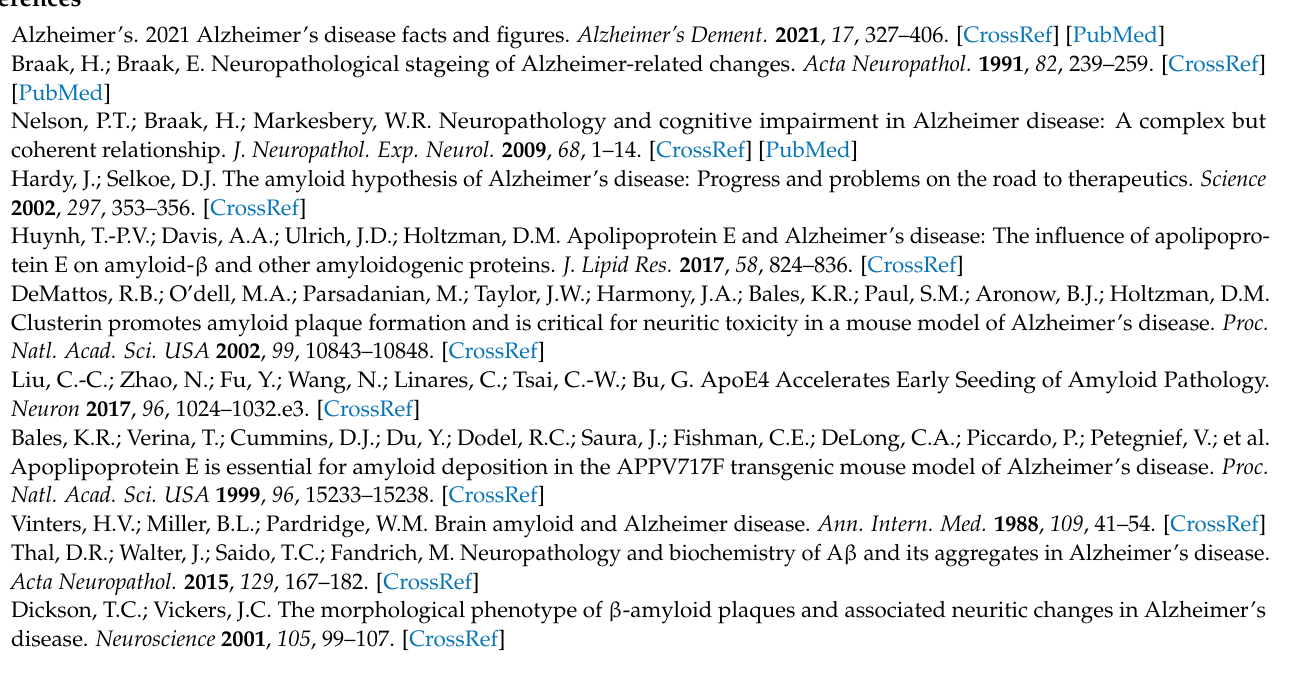
S2: Representative images from tissue sections stained with A β antibodies for animals displayed in Figure 2. Figure S3: Representative images from tissue sections stained with A β antibodies for animals displayed in Figure 3. Figure S4: Representative images from tissue sections stained with A β antibodies for animals displayed in Figure